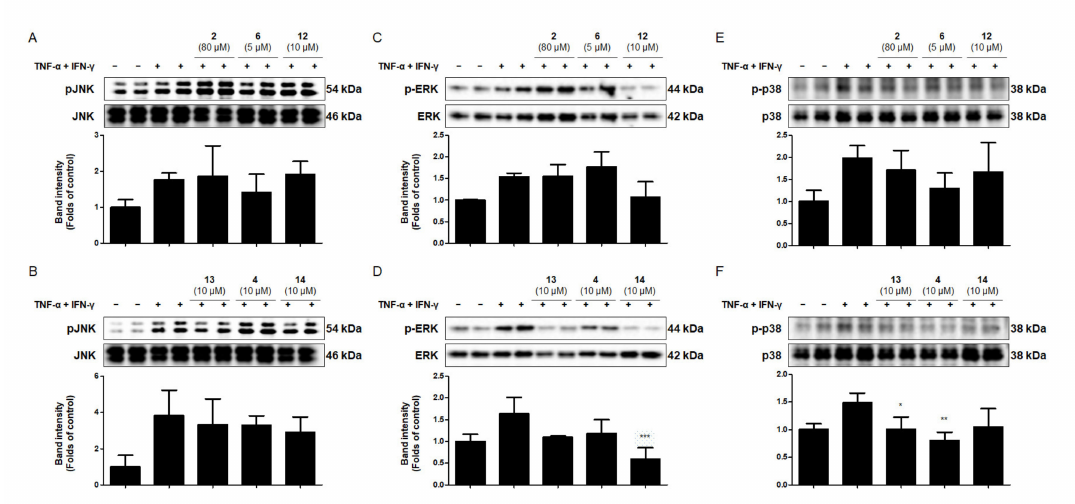
Figure 6. Effect of the six compounds from C. tricuspidata on JNK-1/2, ERK-1/2, and p38 phosphorylation in HaCaT cells. Cells were pretreated with the six compounds at the indicated concentrations for 3 h, and then stimulated with TNF- α + IFN- γ (20 ng/mL) for 2 h ( A , B ), 15 min ( C , D ), or 6 h ( E , F ). Cell extracts were analyzed using Western blotting and antibodies specific for phosphorylated JNK1/2 (p-JNK1/2), p-ERK1/2, or p-p38. The membrane was stripped and reprobed to determine the total abundance of each MAPK, as a control measure. Representative blots from four independent experiments are presented. Immunoblots were quantified using ImageJ software. The band intensity was quantified and normalized to each total protein concentration. * p < 0.05, ** p < 0.01, and *** p < 0.001 compared with TNF- α + IFN- γ